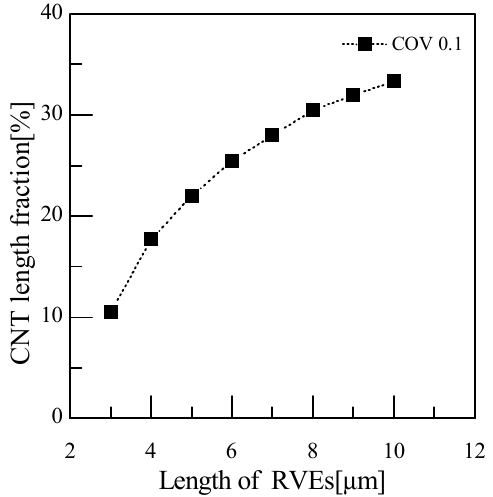
Figure 10. CNT length fraction greater than 2 µm according to the RVE length.